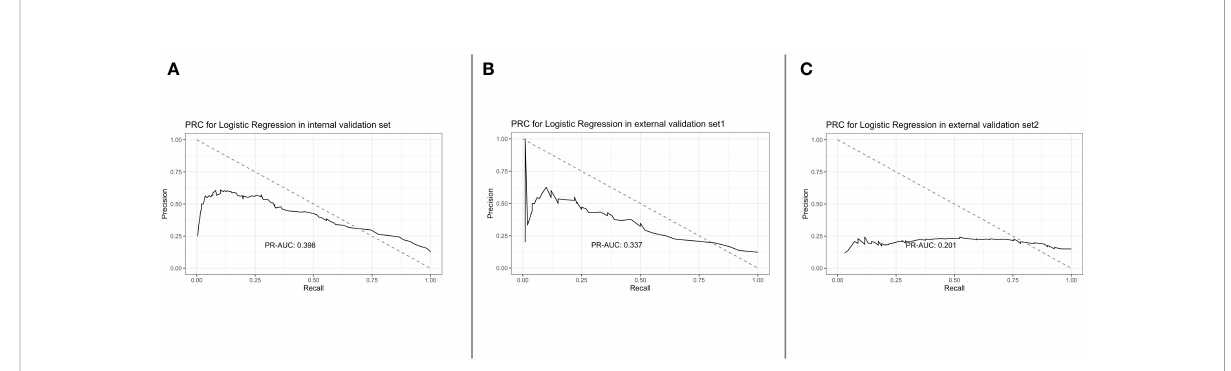
FIGURE 3 PRC for logistic regression in the internal validation set, external validation set 1, and external validation set 2 [from (A) to (C)